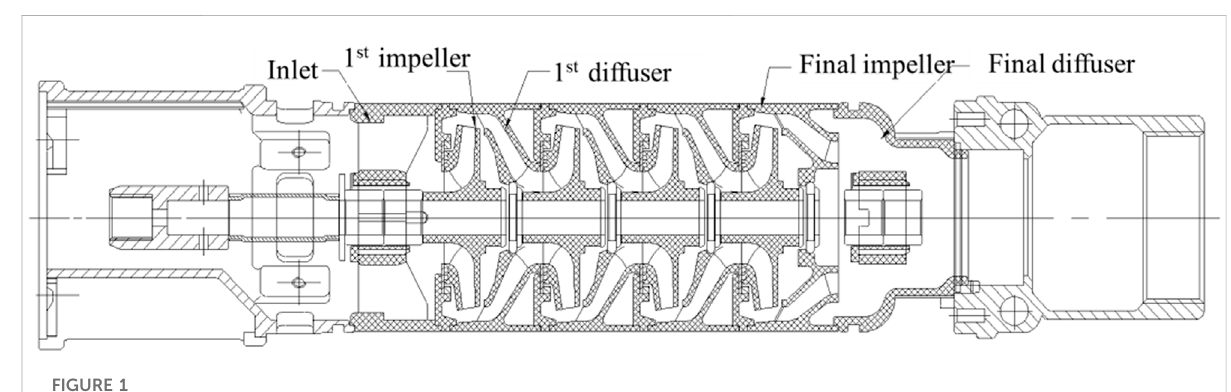
FIGURE 1 Assembly diagram of over fl ow parts of the deep well pump.